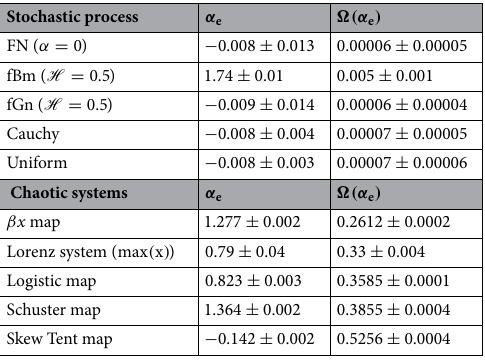
Table 1. Results obtained from stochastic and deterministic time series: mean and standard deviation of the α e parameter and of �(α e ) (Eq. 1), calculated from 1000 time series generated with different initial conditions and noise seeds.